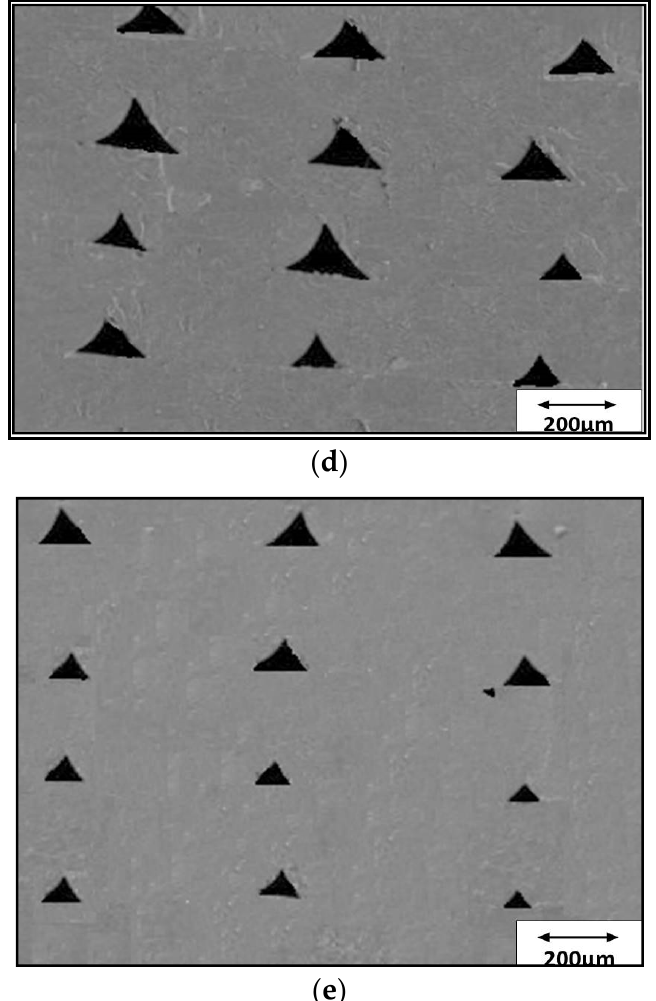
Figure 12. ( a ) SEM of vertical plane section of FDM-printed surface of PC-ABS. ( b ) SEM of vertical plane section of FDM-printed surface of PC-ABS + 0.4 wt % graphene. ( c ) SEM of vertical plane section of FDM-printed surface of PC-ABS + 0.8 wt % graphene. ( d ) SEM of void formation in PC-ABS. ( e ) SEM of void formation in PC-ABS + 0.8 wt % graphene.